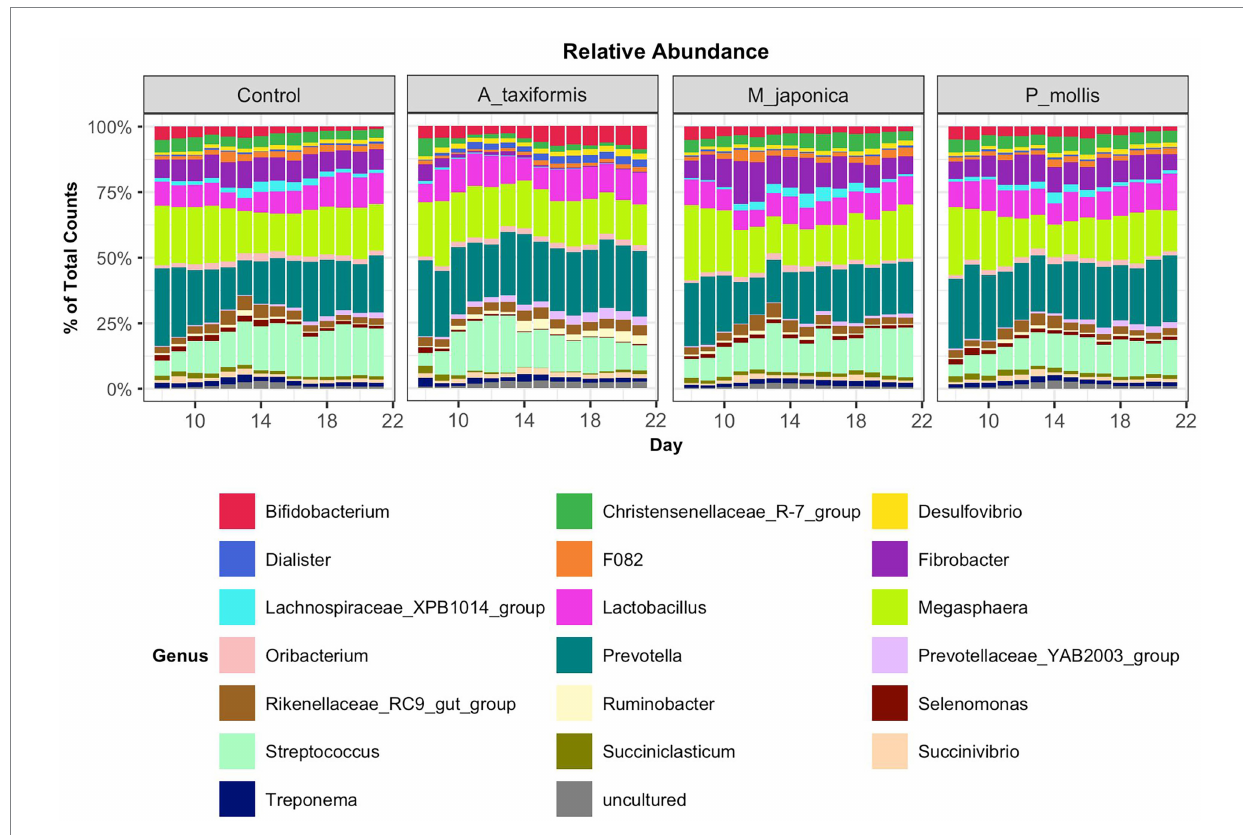
FIGURE 4 Relative abundances of the 20 most abundant genus-level features across all treatment groups. Abundances were scaled to 1 for ease of